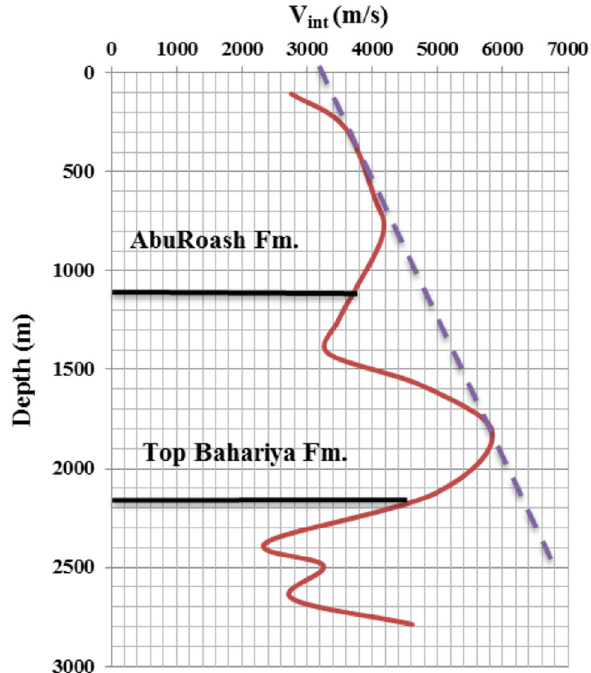
Fig. 5 V int for CDP 120 inline